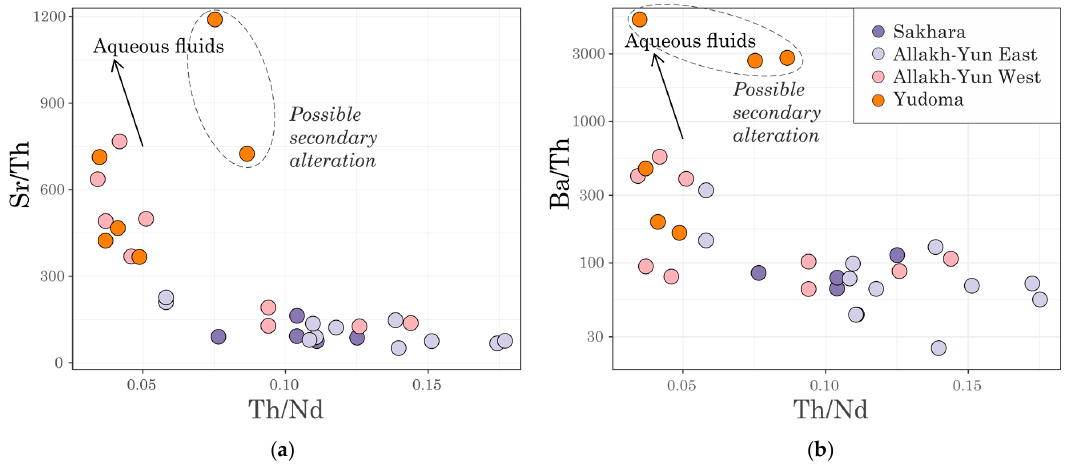
Figure 9. Plots of ( a ) Sr/Th vs. Th/Nd and ( b ) Ba/Th vs. Th/Nd for the Sette-Daban event